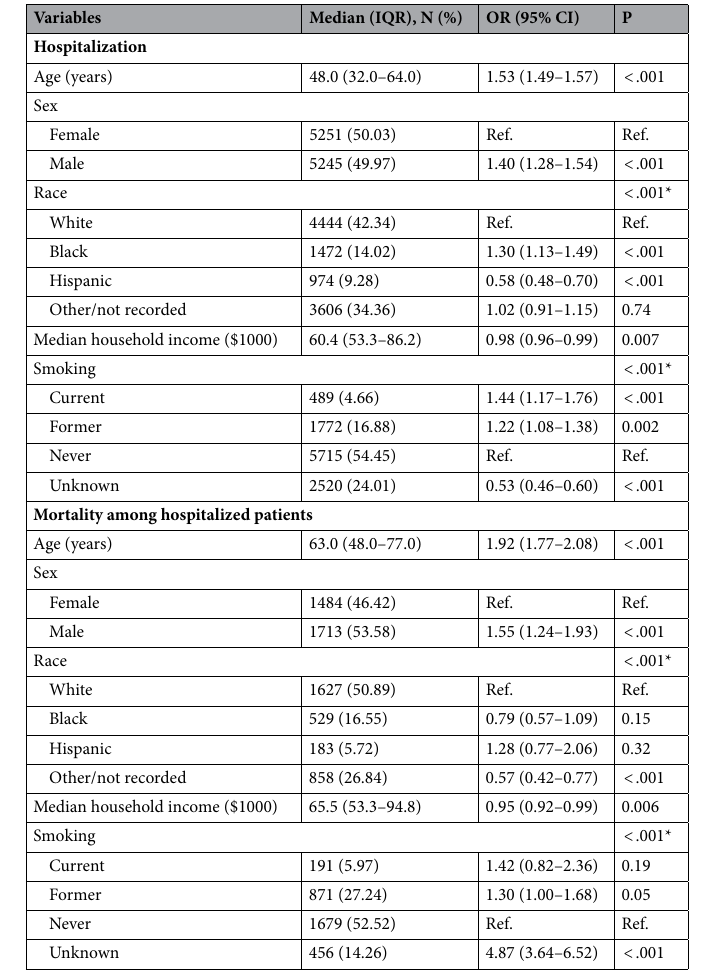
Table 2. Adjusted odds ratios of the examined variables for predicting risk of hospitalization among patients with COVID-19 and risk of mortality for the hospitalized patients (N = 10,496 patients; 30.46% hospitalized). Each variable shown was mutually adjusted for the other variables in the table. IQR: interquartile range. Medians, interquartile ratios, and percentages are reported on the derivation population. Odd ratios (OR) and the corresponding 95% confidence interval (CI) for age is reported per 10 years increment, and these values for median household income are shown per 10,000$. *Test of trend